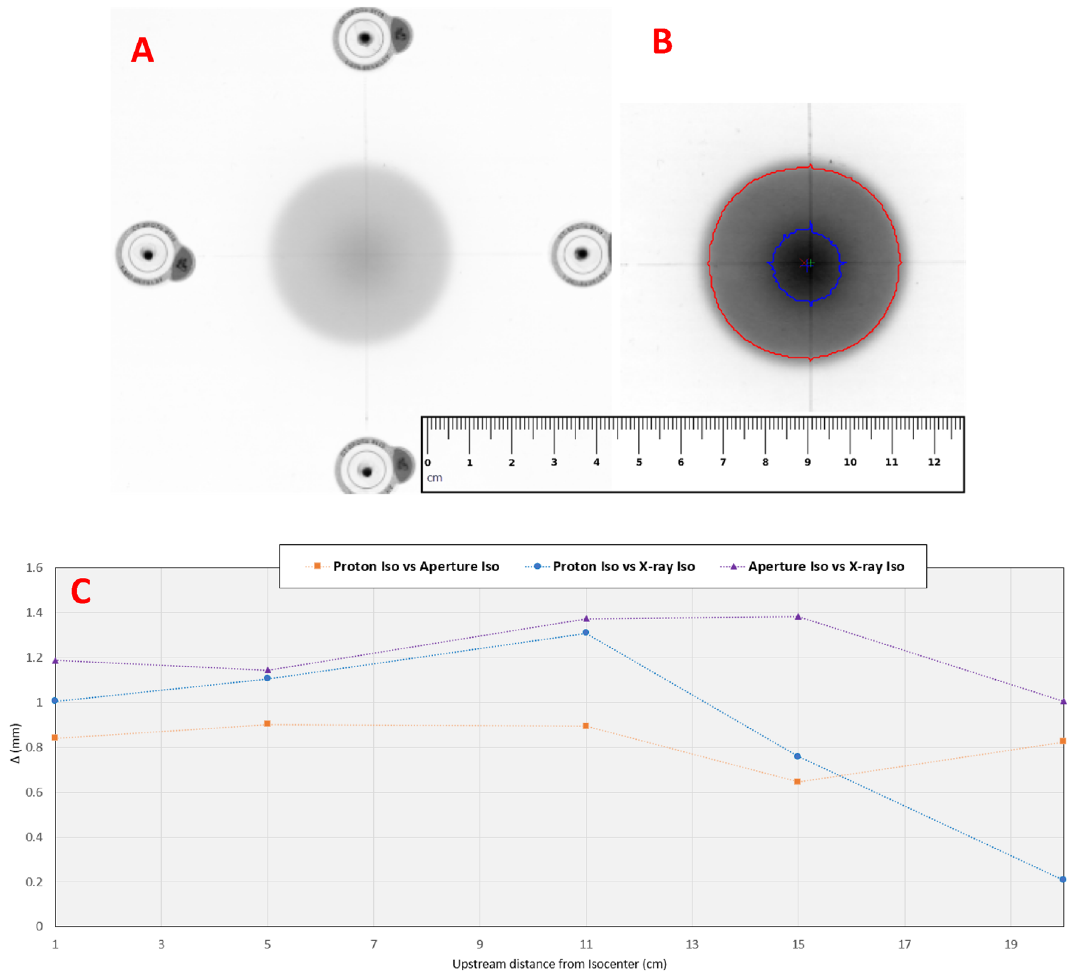
Figure 6. ( A ) An example of an irradiated film used to determine relative errors between imaging, proton beam, and mechanical isocenters. ( B ) Resulting film analysis with proton beam isocenter (blue cross), mechanical isocenter (red cross), and imaging isocenter (green cross). ( C ) Relative alignment errors between proton beam, X-ray, and aperture isocenters as a function of upstream distance from the isocenter plane. The measurement points are shown by markers, the connecting lines are for visualization purposes